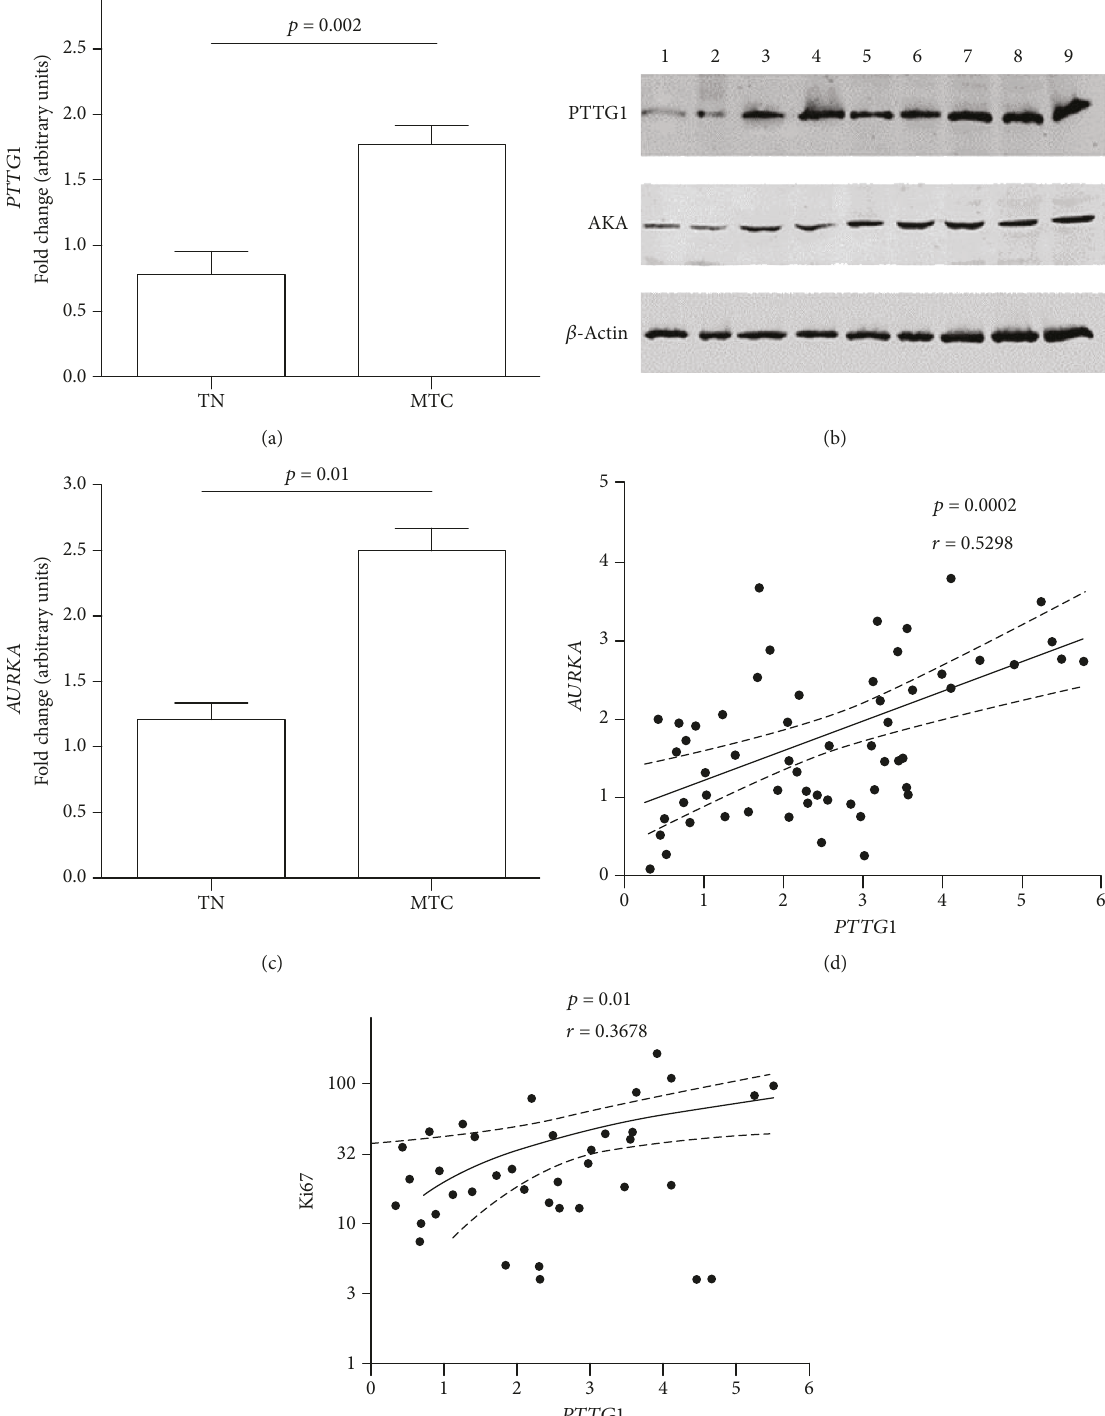
Figure 1: Gene and protein expression levels in MTC patients. (a) AURKA (Aurora kinase A gene) expression in 71 MTC patients evaluated by qPCR (TN =normal thyroid). (b) Representative western blot for PTTG1 and AKA (Aurora kinase A) in 6 MTC patients (3: stage I; 4: stage I; 5: stage III; 6: stage IV; 7: stage II; and 8: stage IV), 2 controls (healthy thyroid, numbers 1 and 2), and 1 patient with papillary thyroid carcinoma (number 9). (c) PTTG1 expression in 71 MTC patients evaluated by qPCR (TN=normal thyroid). (d) Spearman ’ s correlation between PTTG1 and AURKA expression levels for 71 MTC patients evaluated by qPCR. (e) Spearman ’ s correlation between Ki-67 and PTTG1 expression levels for 54 MTC